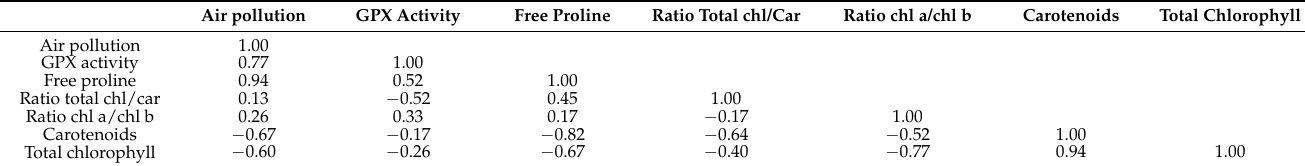
Table 5. Pearson correlations between the level of air pollution and levels of studied biochemical markers in leaves of F. excelsior from four experimental plots (n = 72, 3 individuals × 4 plots × 6 years).